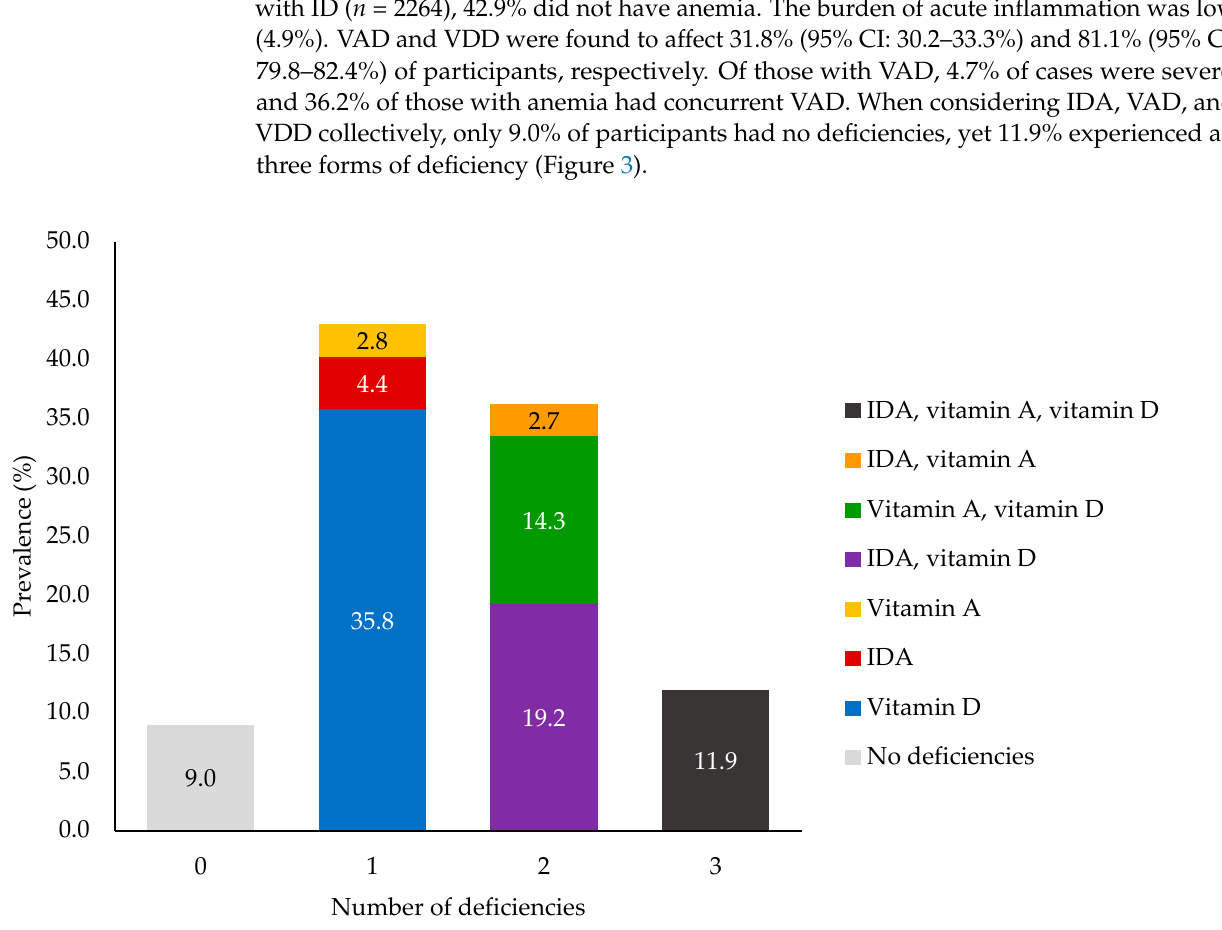
Figure 3. Number and type(s) of deficiencies experienced by late adolescent participants in the MaPPS Trial subgroup ( n = 3382).